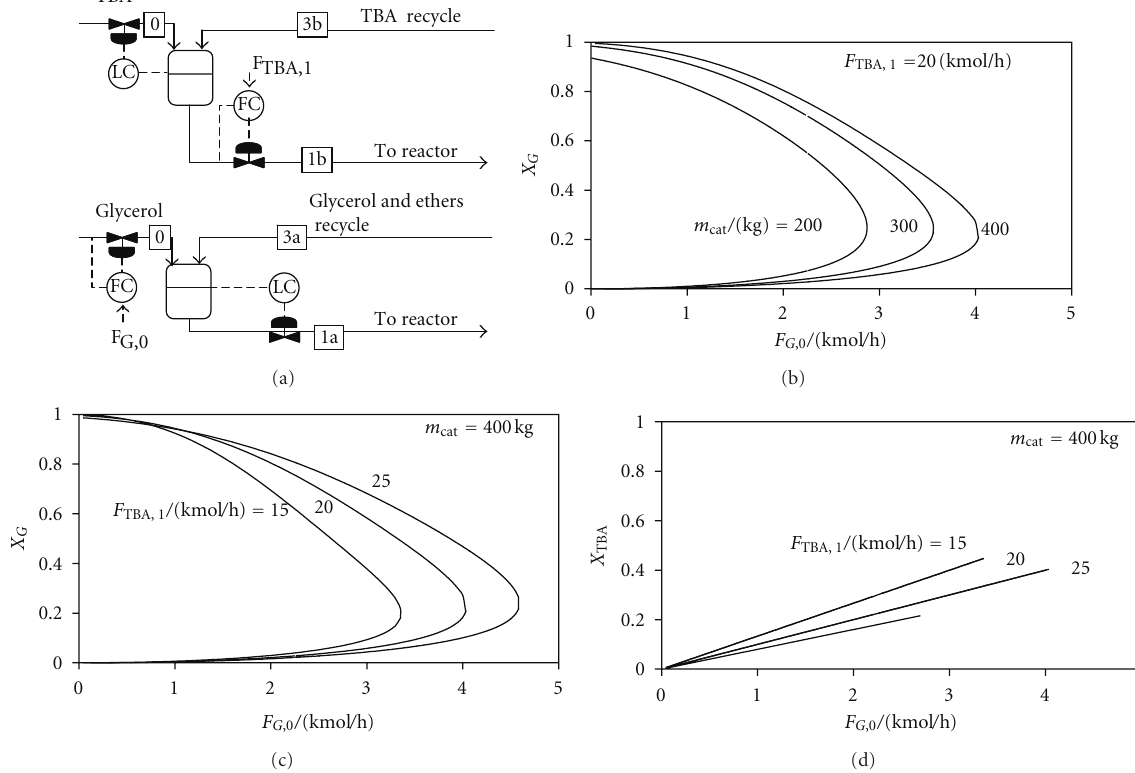
Figure 3: Control structure CS2. Reactants conversions versus fresh glycerol flow rate, for di ff erent values of catalyst mass and reactor-inlet TBA flow